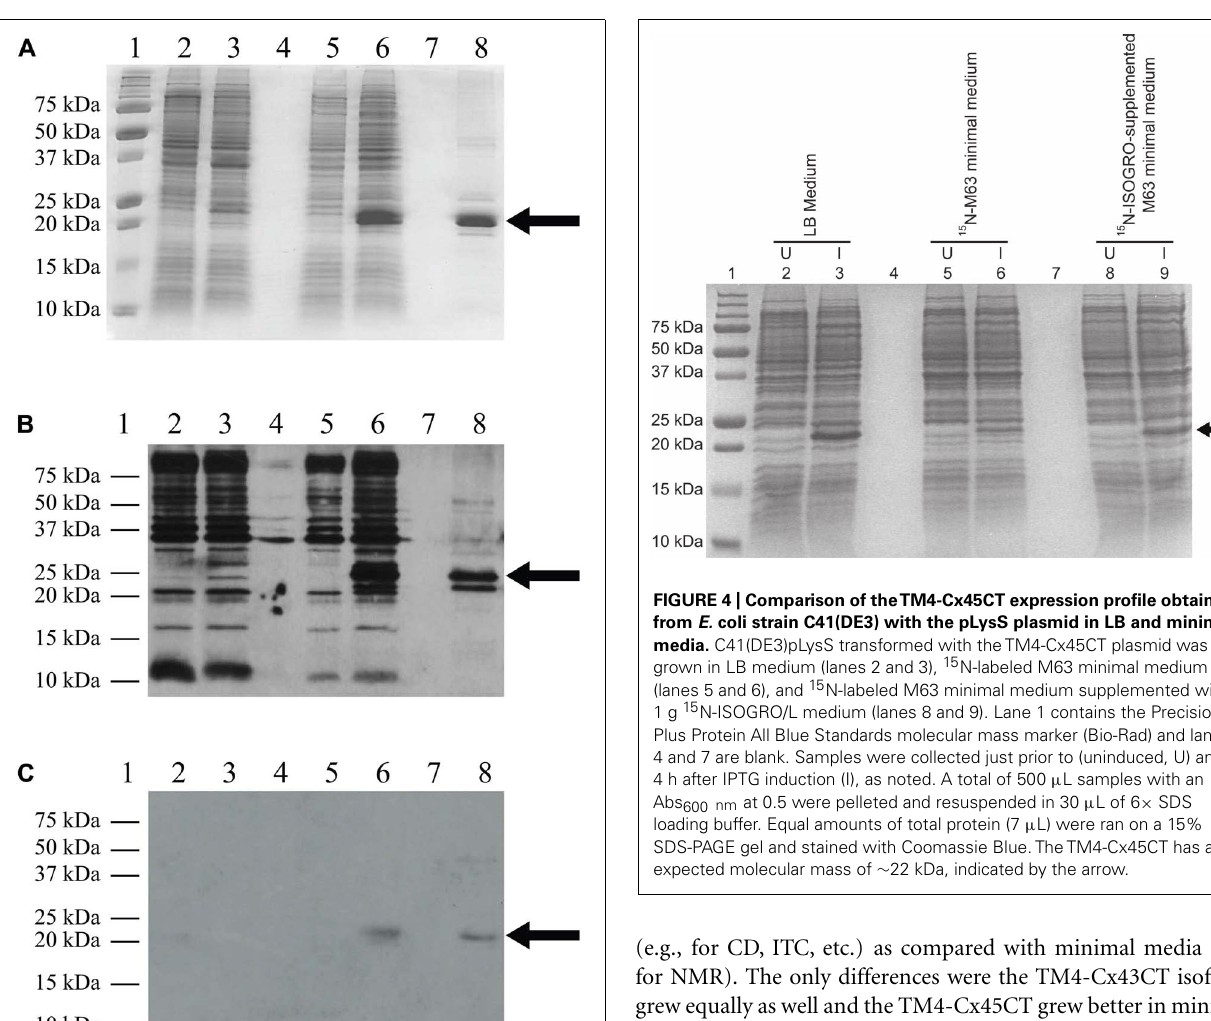
to inhibit protein expression (Kim and Lee, 2006). In addition,